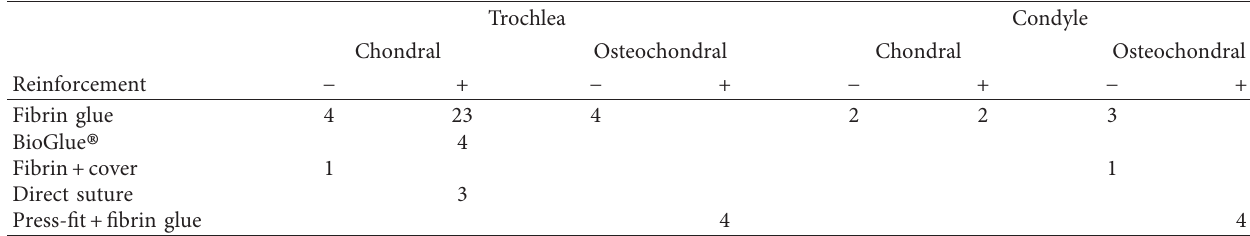
Figure 1: Study design. Table 1: Overview of the number of defects per group and fixation method for the 2–4 week study. 12 minipigs with trochlea chondral defects with reinforced hydrogels and fibrin glue fixation were euthanized after 2 weeks, and all other animals were euthanized after 4